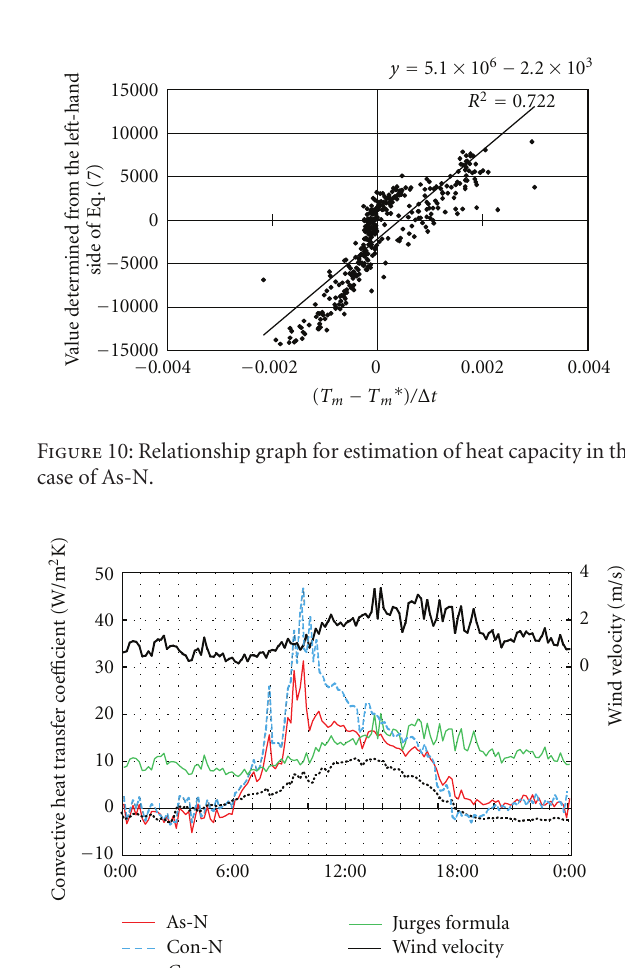
Figure 9: Relationship graph for estimation of heat conductivity in the case of As-N.